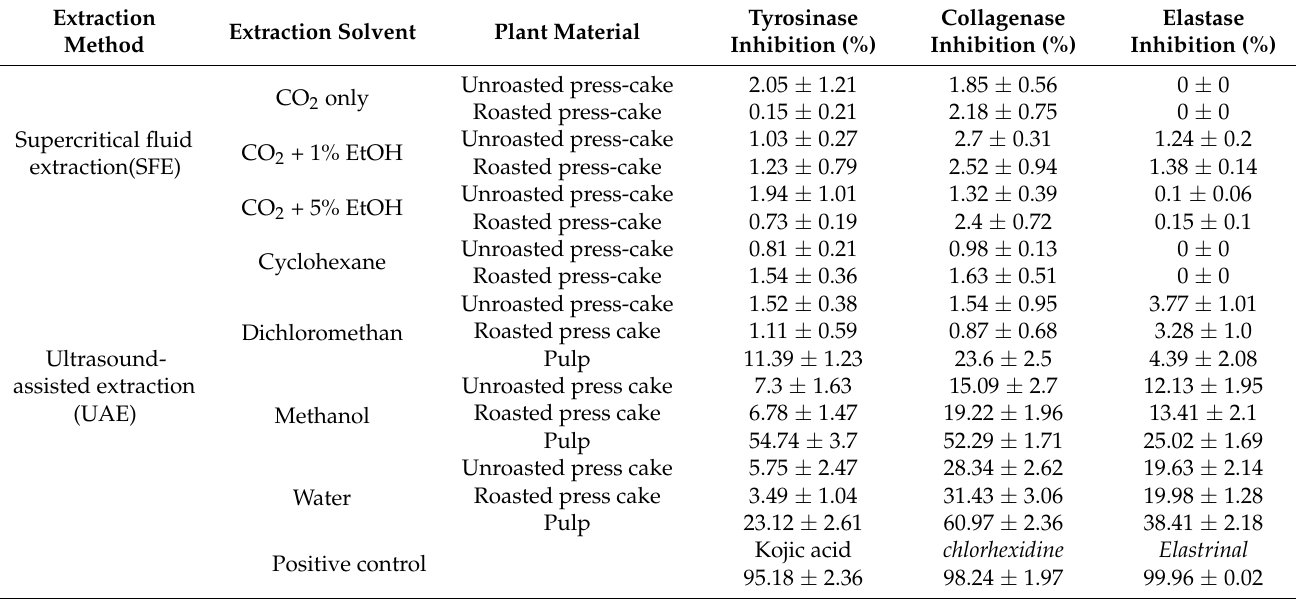
Table 1. Percentages (mean values ± standard deviation) of tyrosinase inhibition by argan cake and pulp extracts at 200 µ